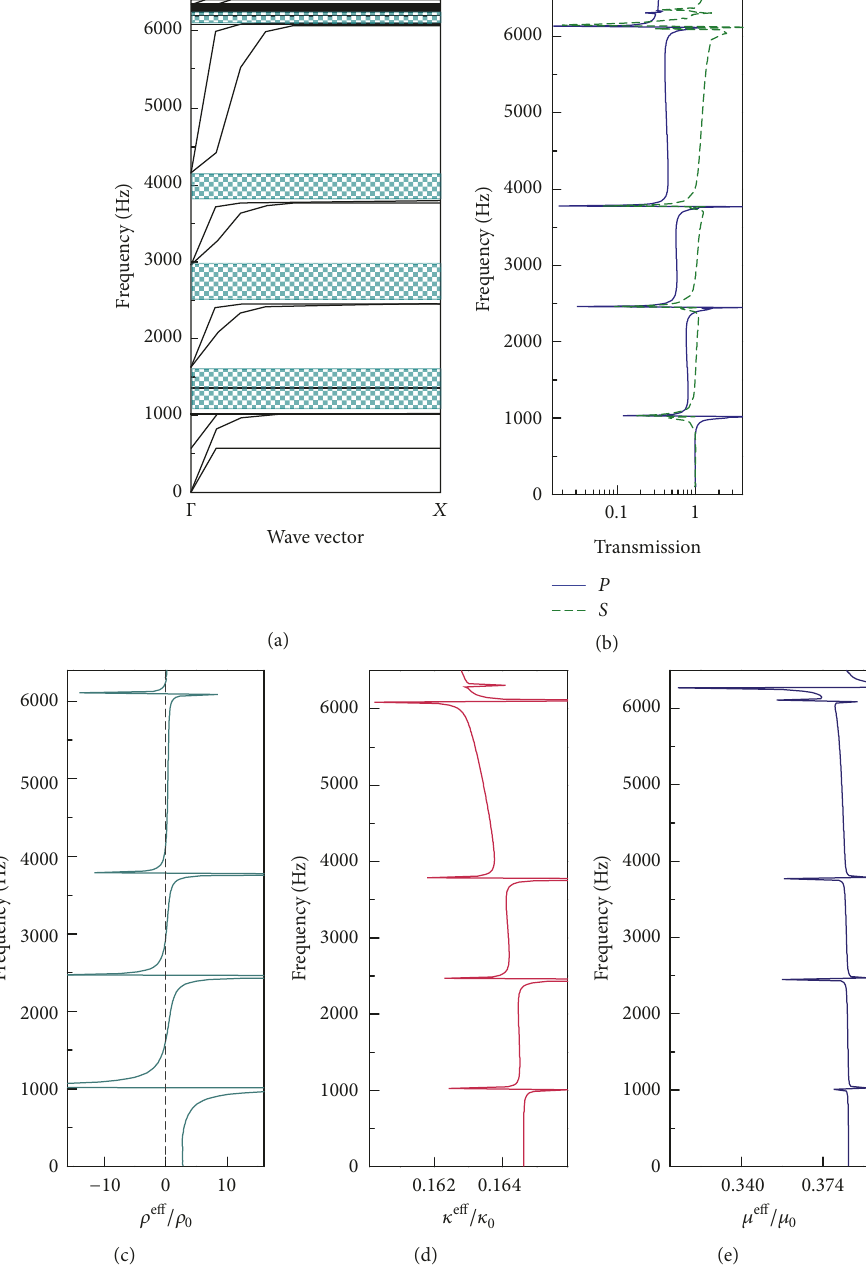
Figure 6: Band structure of triple-oscillator acoustic metamaterial in the Γ𝑋 direction (a); transmission characteristic curve in the Γ𝑋 direction (b); normalized effective mass density, effective bulk modulus, and effective shear modulus (c–e).